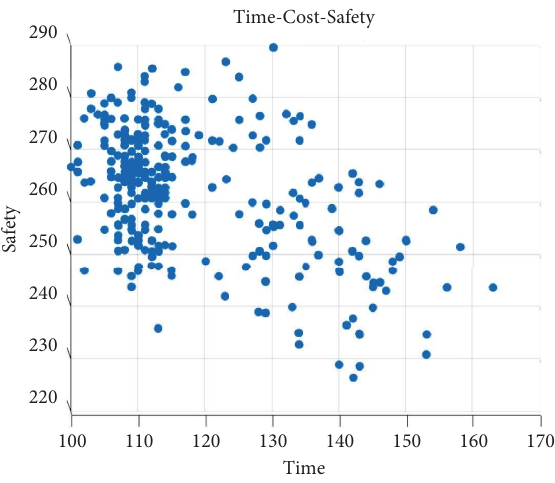
Figure 17: Time-safety trade-of.